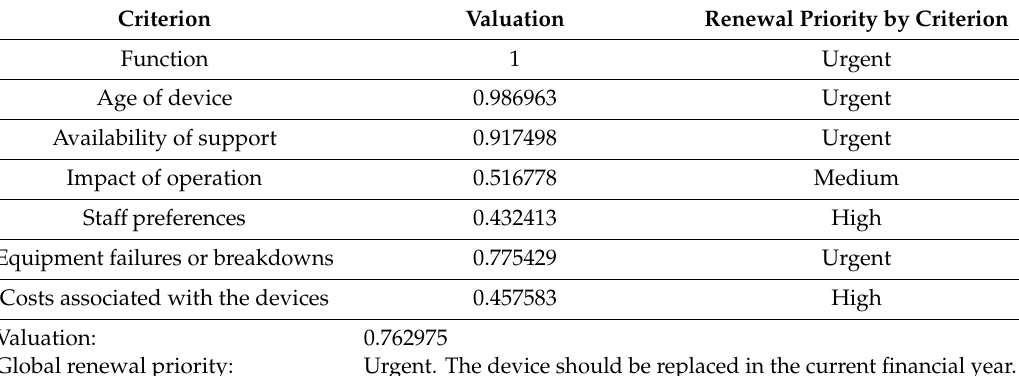
Table 27. Results for neonatal ventilator.